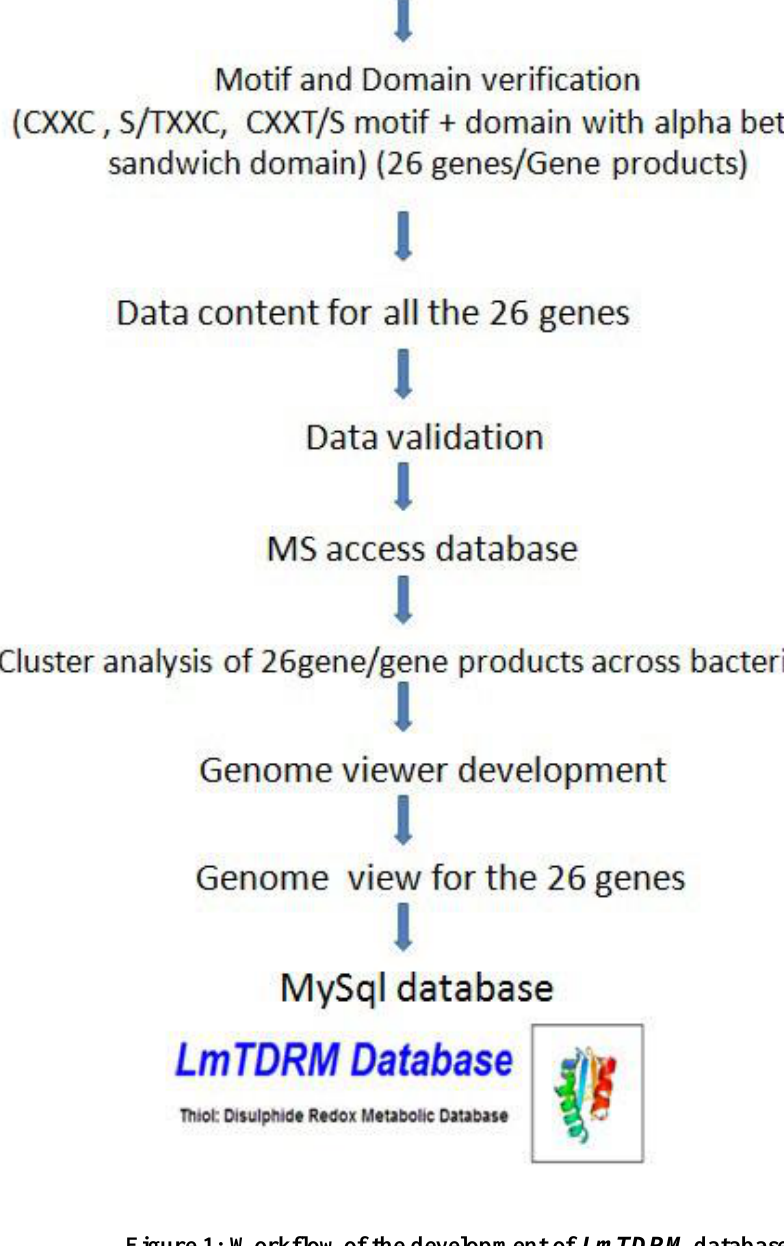
Figure 1: Workflow of the development of LmTDRM